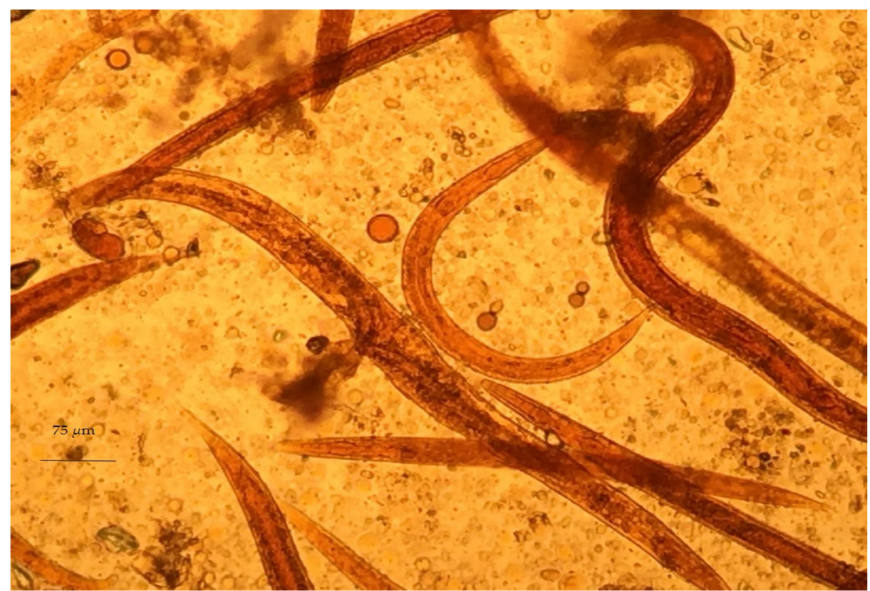
Figure 3. Haemonchus L 2 , as seen during microscopic observation.